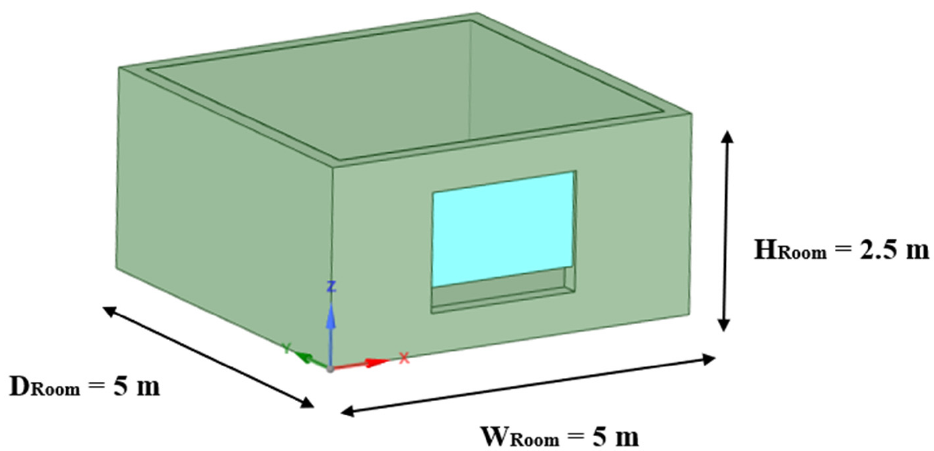
Figure 3. The layout of the rooms on each floor (R—Room, N—North, W—West, S—South, E— East, G—Ground floor, F—First floor).